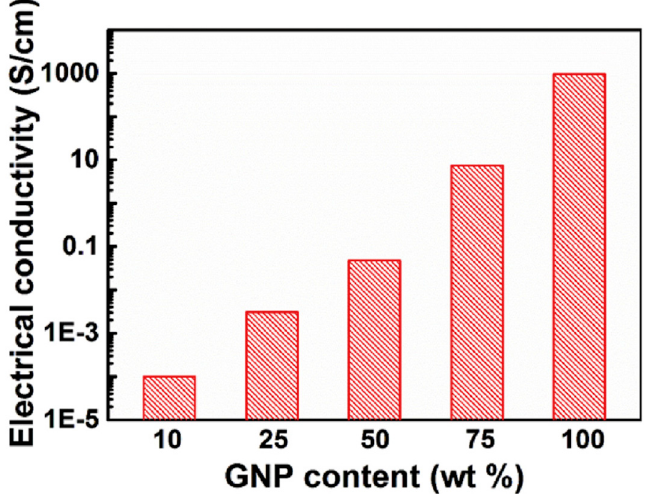
Figure 4. The electrical conductivity of GNP/NFC composite paper measured with different amounts of GNPs (Reproduced with permission [47]).